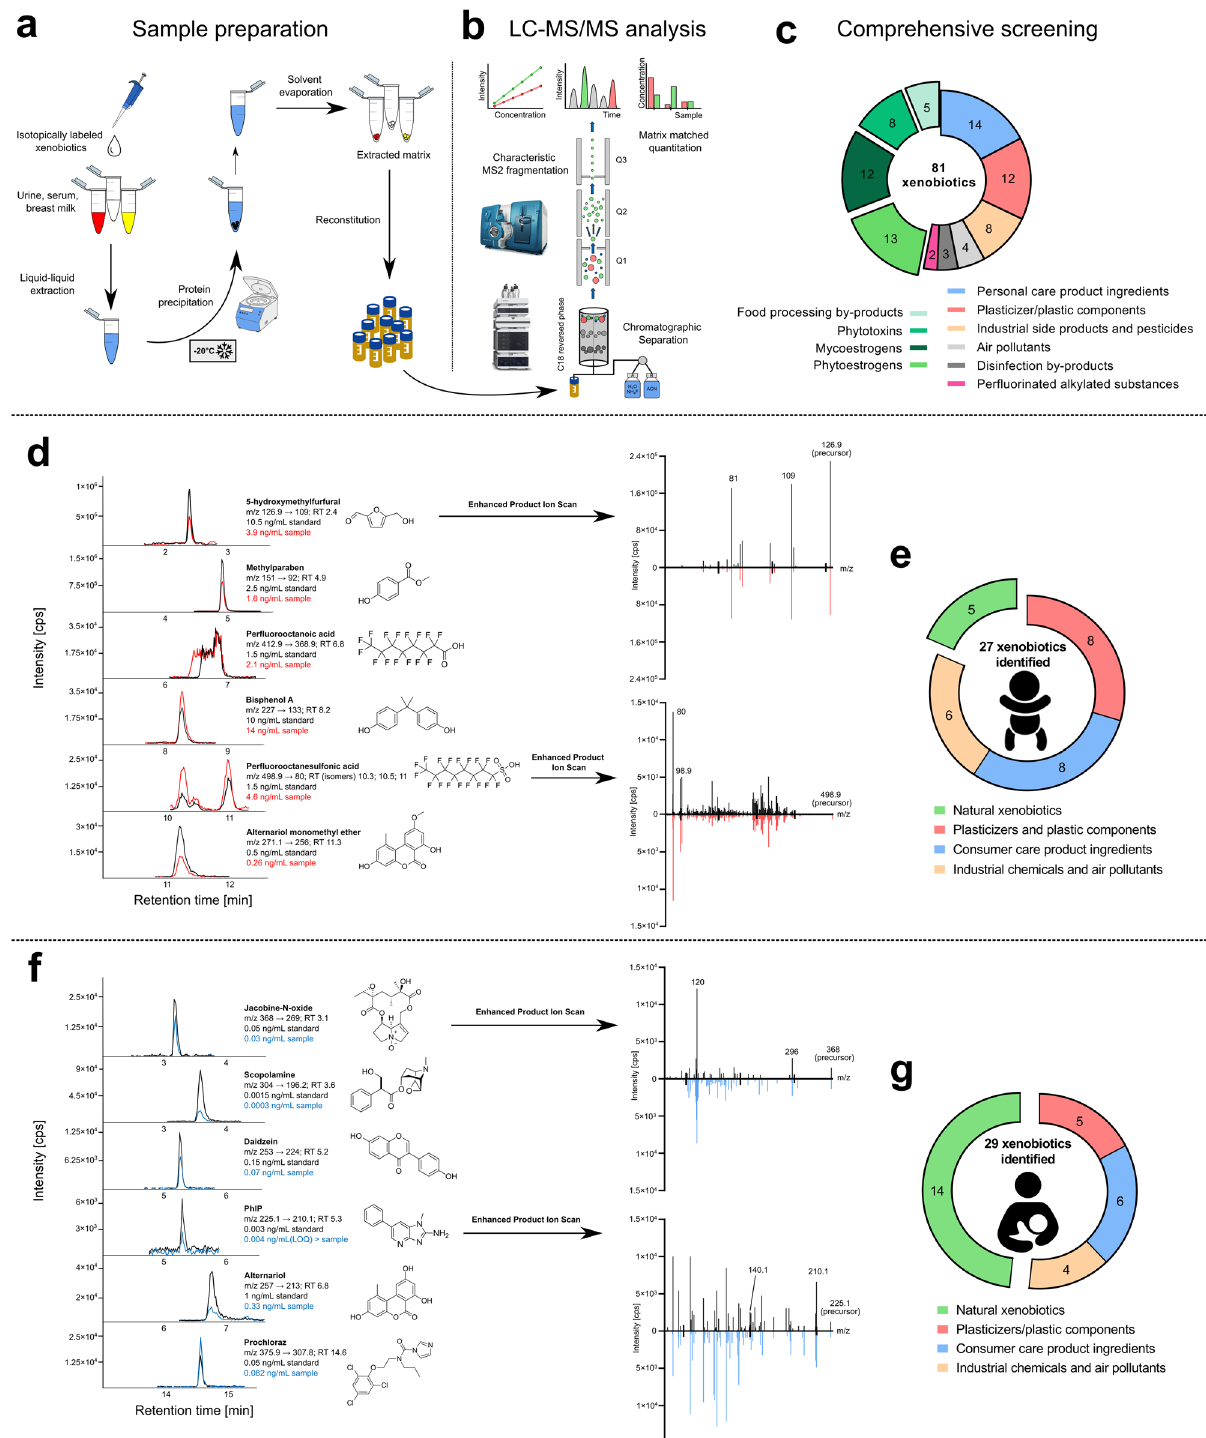
Fig. 2 Analytical work fl ow, compound panel and identi fi ed analytes in neonatal plasma and breast milk. a , b Overview of the generic sample preparation and LC-MS/MS work fl ow developed. c Included chemical classes. Chromatograms from scheduled multiple reaction monitoring (sMRM) show the transitions used to quantitate selected analytes in infant plasma and breast milk. Chromatograms for the corresponding matrix-matched standards are plotted in black, while the plasma ( d ) and breast milk ( f ) samples are displayed in red and blue, respectively. MS 2 spectra generated from enhanced product ion scans (EPIs) of reference standards are compared to the spectra acquired in biological samples for selected analytes (5-hydroxymethylfurfural, per fl uorooctanesulfonic acid, jacobine-N-oxide and PhIP; technical details of EPI scans are provided in the Online Methods section). The precursor ion m/z is annotated together with fragment ions that were used for quantitative and qualitative measurements. Source data are provided as a Source Data fi le. Pie charts indicate the distribution of the detected compounds in neonate plasma ( e ) and breast milk ( g ) samples according to origin or chemical classi fi